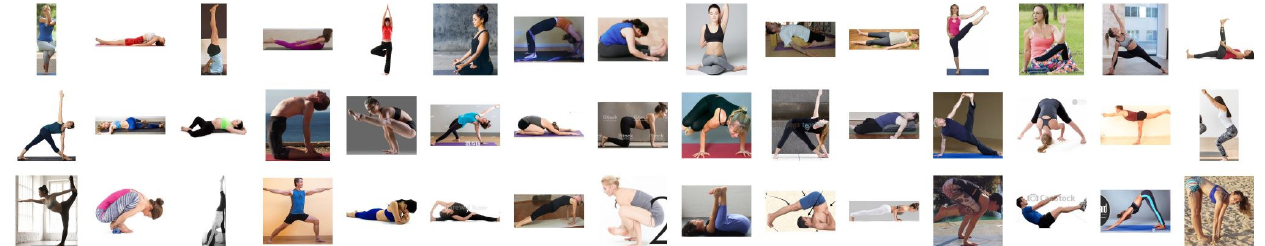
Figure 4. An overview of 45 categories of yoga poses in Dataset A.